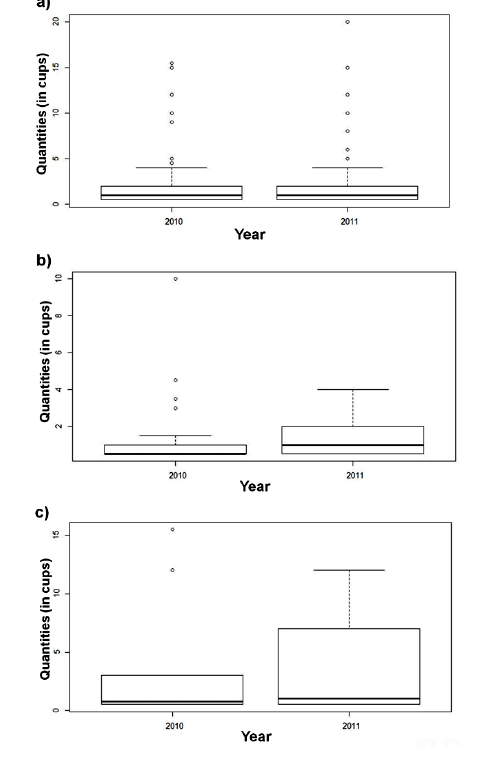
Fig. 7 . Distribution of acquired seed quantities over the two seasons: a) in the whole sample, b) for partners that are in-laws, and c) for